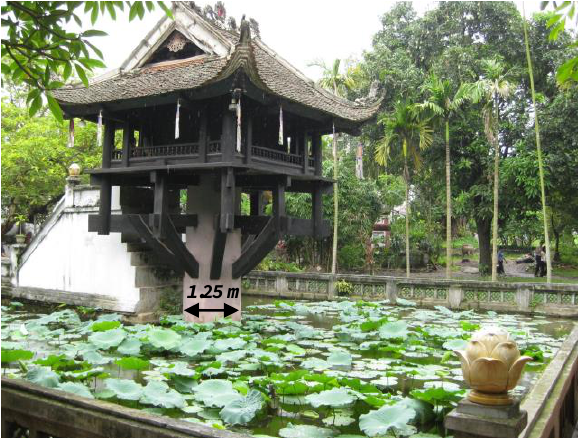
Figure 1. “One pilla” pogoda, Hanoi, Vietnam (modification